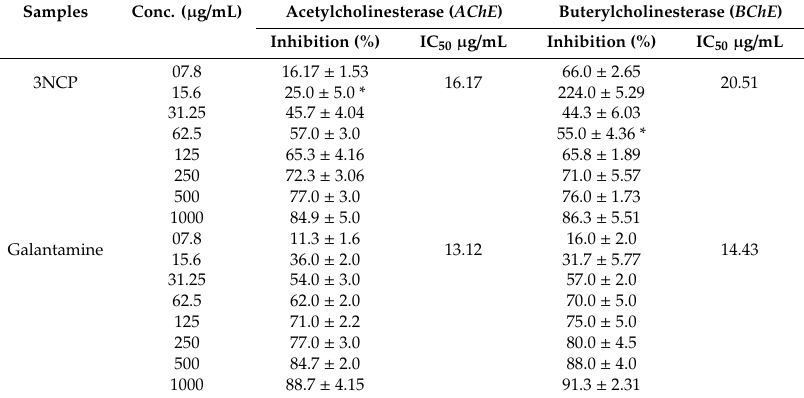
Results of in vitro cholinesterases inhibitory assay of 2-(hydroxy-(3-nitrophenyl) nitrophenyl)methyl)cyclopentanone.